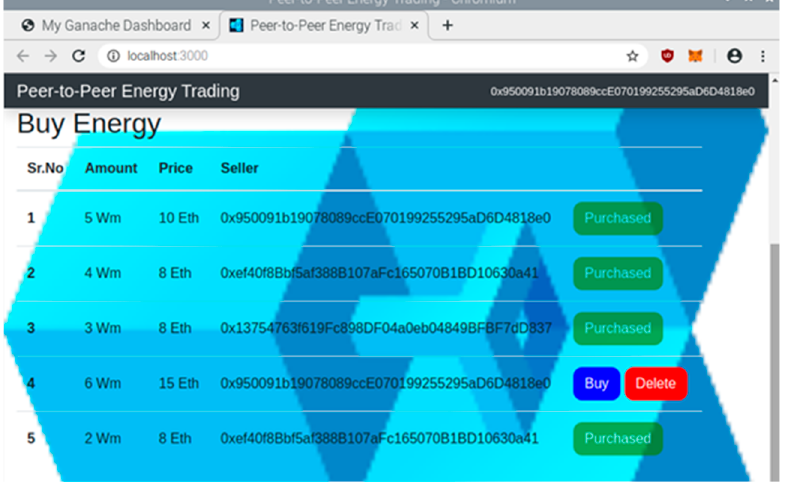
Figure 18. IoT server status.